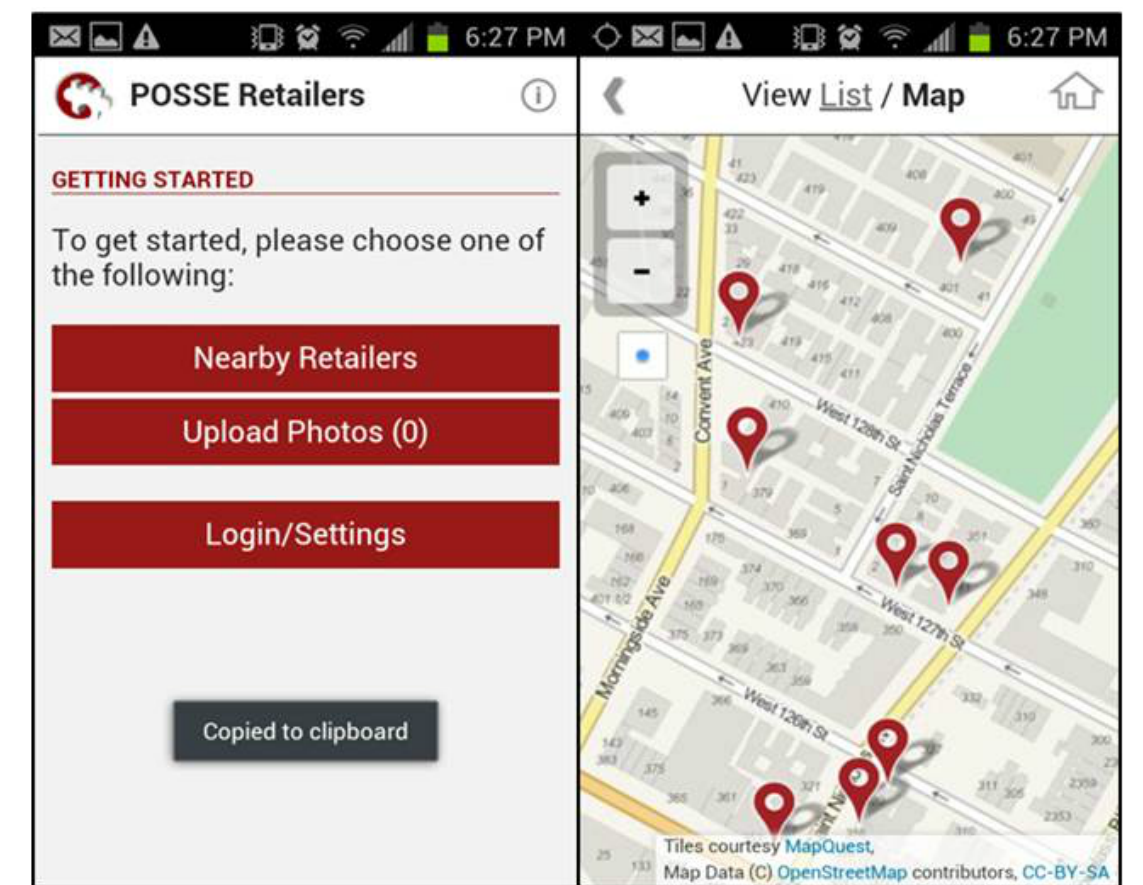
Figure 2. Mobile app for NYC (map